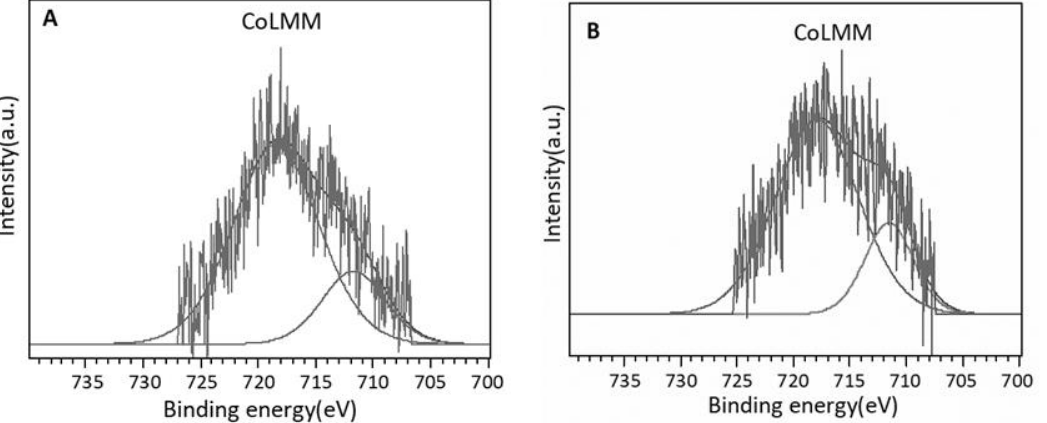
Figure 3. CoLMM Auger region spectra and deconvolutions: ( A ) Co-ZnAl; ( B ) PdCo-ZnAl.